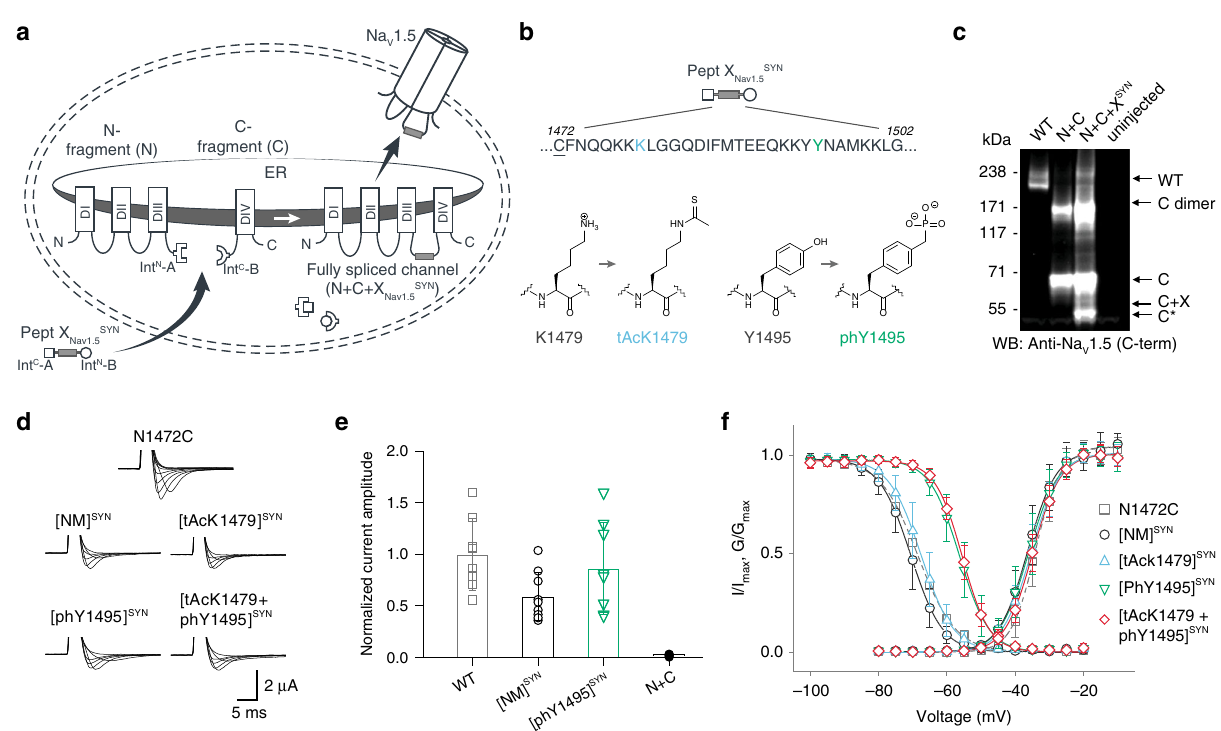
Fig. 3 Insertion of synthetic peptides into NaV1.5. a Schematic of strategy to reconstruct full-length Na V 1.5 from recombinantly expressed N-/C-terminal fragments (N and C) and a synthetic peptide (X Nav1.5 SYN ) in Xenopus laevis oocytes. Inteins A ( Cfa DnaE) and B ( Ssp DnaB M86 ) indicated by square and round symbols, respectively. Note: we cannot exclude that splicing takes place at a different subcellular location than depicted. b Peptide X Nav1.5 SYN sequence corresponding to amino acids replaced in the Na V 1.5 DIII – DIV linker and chemical structures of native amino acids and PTM mimics (tAcK/phY) incorporated via chemical synthesis of peptide X Nav1.5 SYN . The N1472C (underlined) mutation was introduced to optimize splicing (Supplementary Fig. 1). c Immunoblot verifying the presence of fully spliced Na V 1.5 only when peptide X Nav1.5 SYN was co-injected with N and C. Black arrows indicate band positions of the respective constructs (Actual MW of constructs: WT, 227 kDa; C, 79 kDa; C + X, 65 kDa; C-terminal cleavage product, C*, 58 kDa). Band at ~150 kDa is possibly a dimer or aggregate of C. d Representative sodium currents (see Methods; only voltage steps from − 50 to + 10 mV in 10 mV steps are displayed), demonstrating expression of functional Na V 1.5 when Xenopus laevis oocytes expressing N and C constructs were injected with synthetic peptides containing non-modi fi able side chains in positions 1479 and 1495 (K1479R and Y1495F, NM), tAcK1479 or phY1495 or both PTM mimics together. e Average current amplitudes recorded at − 35 mV from oocytes expressing N and C constructs and injected with synthetic peptide variant NM or phY1495 depicted as a bar plot (mean + / – SD; WT, n = 8; NM, n = 9; phY, n = 8; N + C, n = 6). Currents normalized to mean currents measured from oocytes expressing the full-length WT construct. To ensure adequate control of voltage clamp, [Na + ] in the extracellular recording solution was reduced (see Supplementary Fig. 3 for details). f Steady-state inactivation and conductance – voltage (G – V) relationships for PTM-modi fi ed/non-modi fi ed constructs (values displayed as mean + / – SD; N1472C, n = 15; NM, n = 10; tAcK1479, n = 21; phY1495, n = 19; tAcK1479 + phY1495, n = 14). Source data are provided as a Source data fi